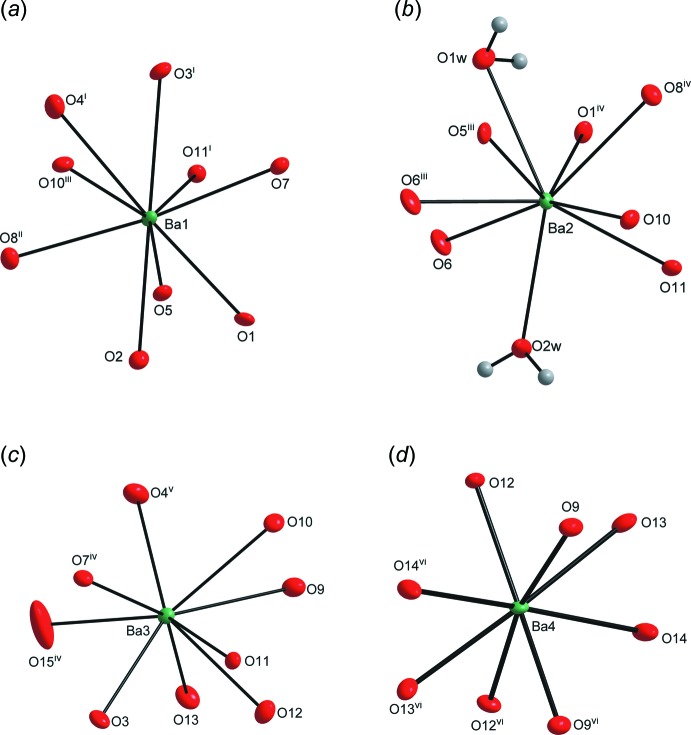
A view of the oxygen coordination around the cations, with displacement ellipsoids shown at the 50% probability level. (a) Ba12+, (b) Ba22+, (c) Ba32+ and (d) Ba42+ [Symmetry codes: (i) x − , −y + , −z + 1; (ii) −x + , y + , z; (iii) −x + 1, −y + 1, −z + 1; (iv) x + , −y + , −z + 1; (v) x + , y + , z; (vi) −x + 1, y, −z + ].